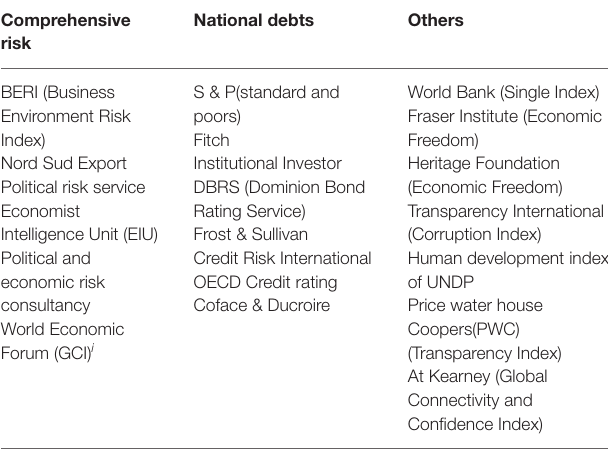
TABLE 1 | Agencies studies macro investment